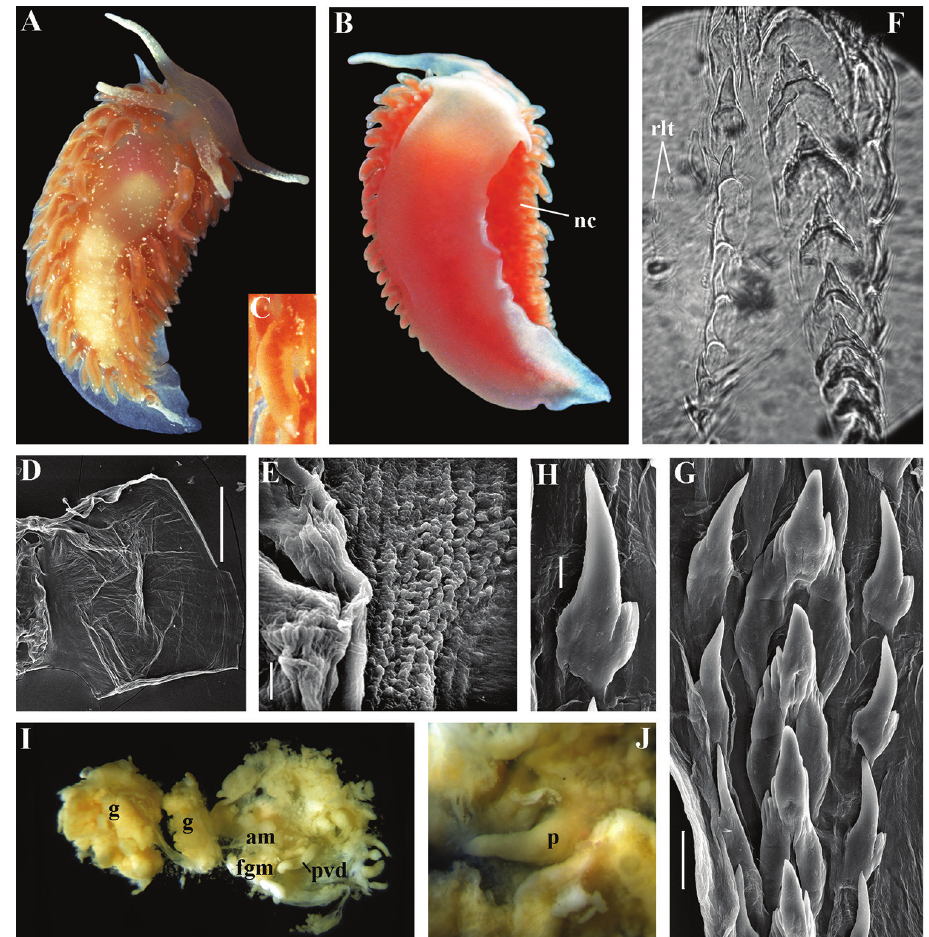
Figure 8. Paracoryphella ignicrystalla sp. n. ZMMU Op-490. The Sea of Japan, Vostok Bay, living speci- men 11.5 mm in fixed length: A dorsal view B ventral view C details of cerata D jaw, SEM E details of masticatory process of jaw, SEM F radular teeth, posterior part, showing second rudimentary row of lateral teeth ( rlt ), light microscopy G radular teeth, posterior part, SEM H lateral tooth, close up, SEM I dissected anterior part showing pharynx and reproductive system J ventral anterior part of fixed specimen showing external non-retractable penis ( p ). Abbreviations: am ampulla fgm female gland mass g gonad nc continuous notal edge p penis pvd prostatic vas deferens rlt rudimentary lateral teeth (second additional rudimentary row of lateral teeth); Scale bars: D = 100 μm; E, G = 30 μm; H = 10 μm. Photos and SEM images by A.V.